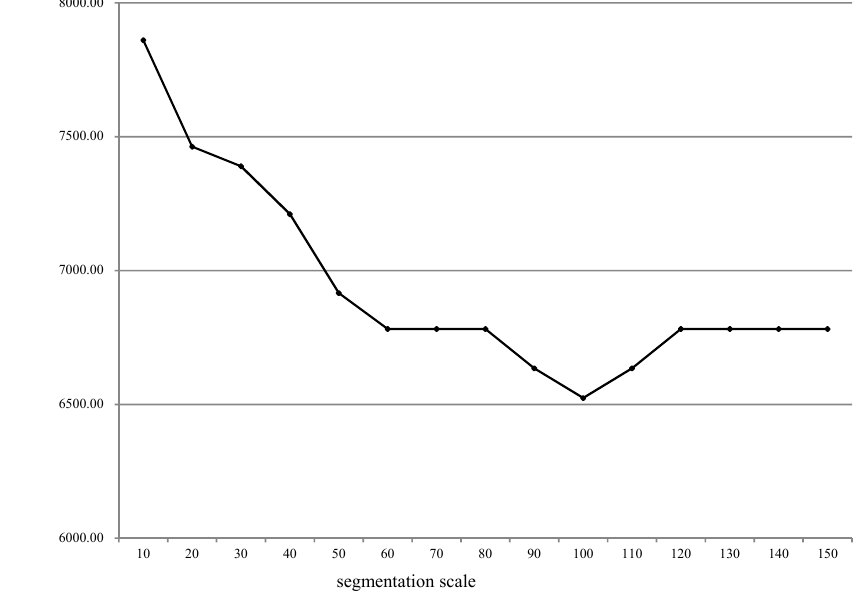
Figure 5. Overall errors of change detection with different segmentation scales, with L1 as the basis image in the first study area.